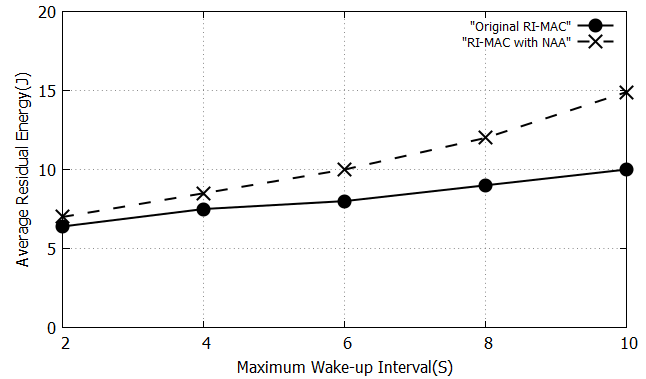
Figure 4. Energy efficiency according to maximum wake-up interval.